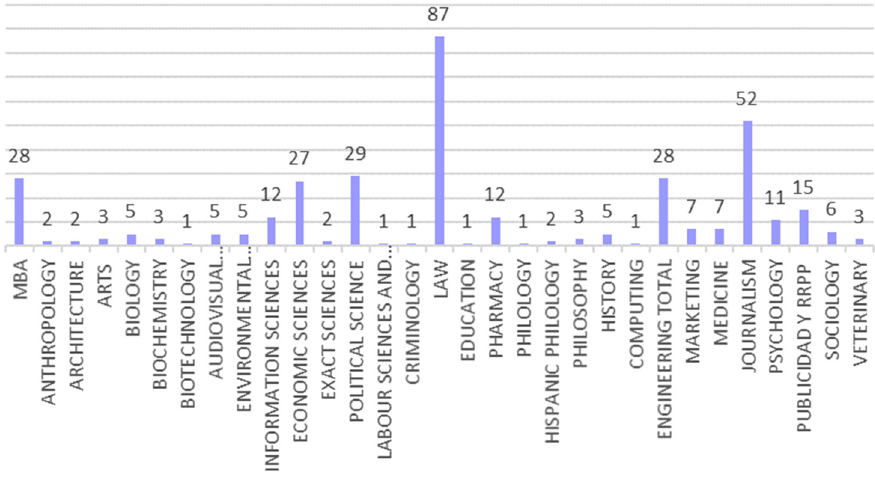
Figure 1. Distribution of lobbyists’ undergraduate degrees held. Source: own elaboration.